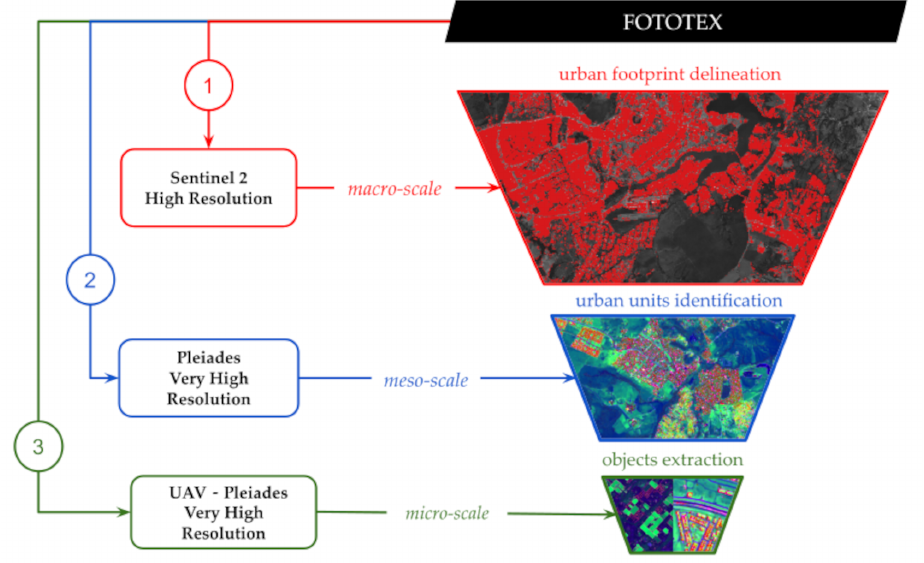
Figure 2. Potential of FOTOTEX for the multi-scale characterization of urban landscapes, with the scales of analysis and associated Earth observation